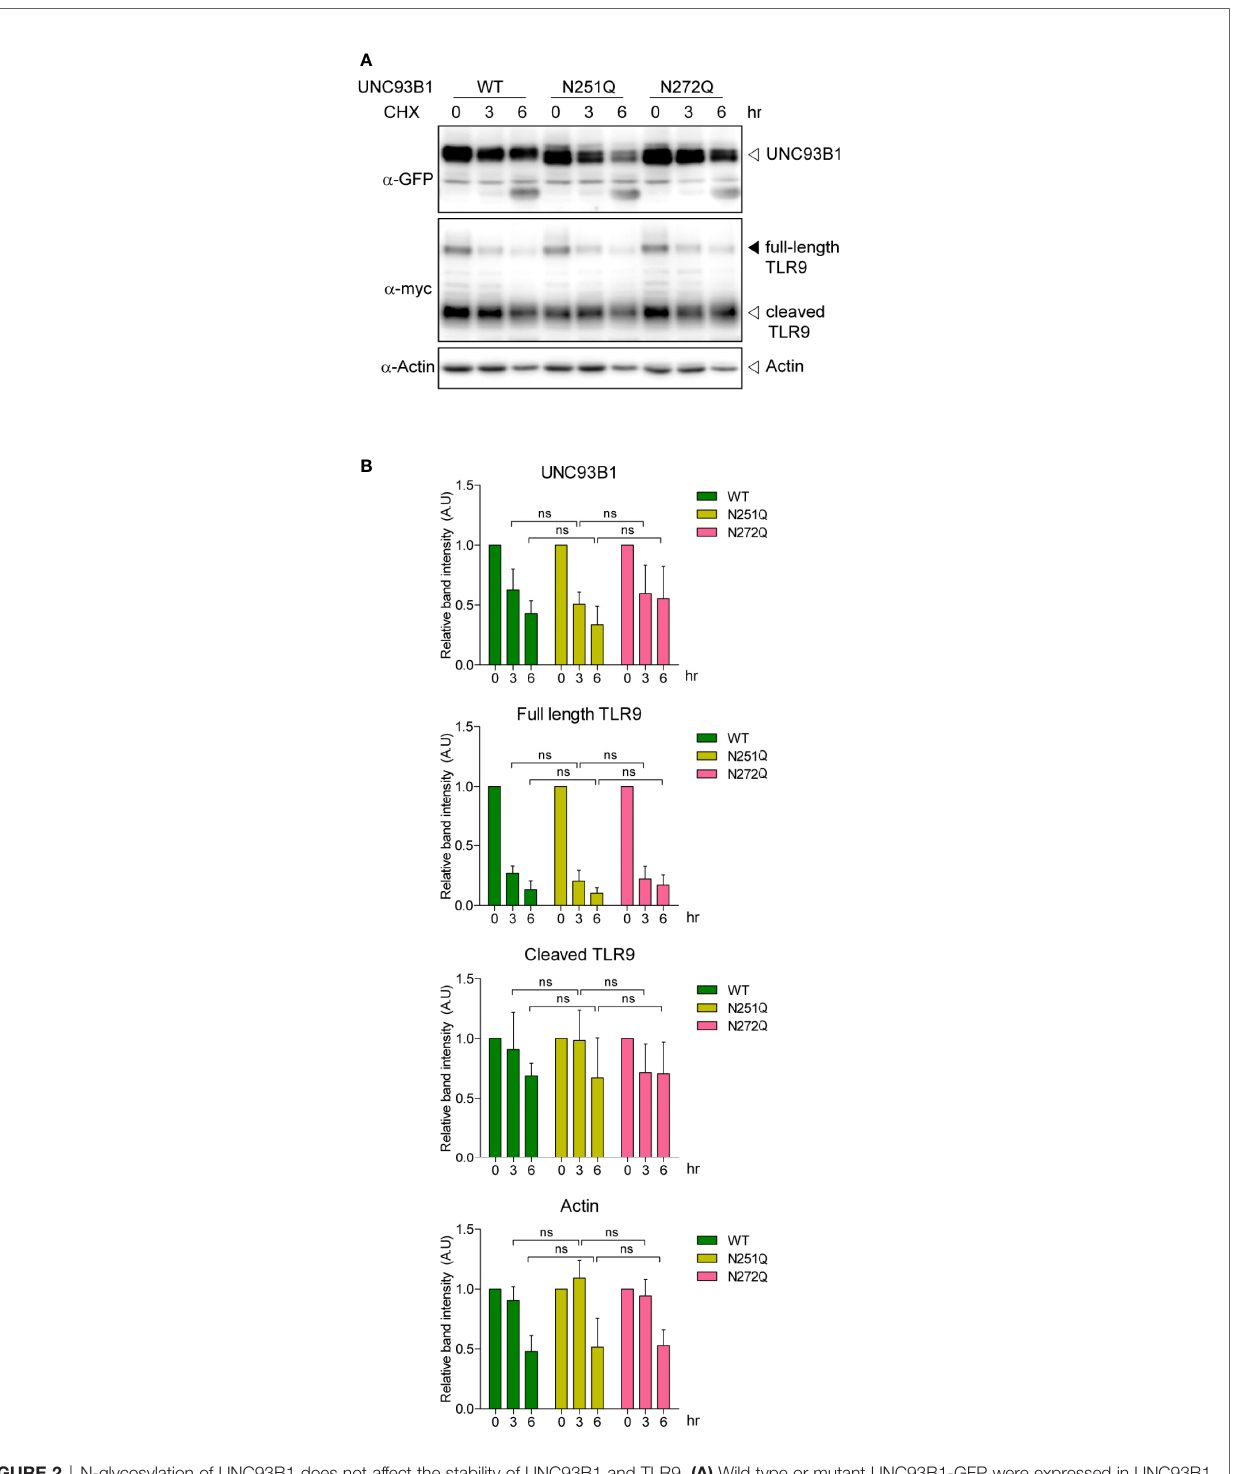
FIGURE 2 | N-glycosylation of UNC93B1 does not affect the stability of UNC93B1 and TLR9. (A) Wild type or mutant UNC93B1-GFP were expressed in UNC93B1 KO iBMDMs together with TLR9-myc. After inhibition of protein synthesis with 20 m g/ml cycloheximide for indicated time periods, cells were lysed and the lysates were loaded on an SDS-PAGE gel. After electrophoresis and protein transfer, UNC93B1-GFP, TLR9-myc, and actin in a single transfer membrane were sequentially detected by immunoblotting with anti-GFP, anti-myc, and anti-actin antibody, respectively. (B) The relative band intensity of UNC93B1, full-length TLR9, cleaved TLR9, and actin at each time point was calculated by dividing the band intensity of individual protein at the indicated time point with that at 0 h. Data represent means ± SD (n = 3). ns, not signi fi cant (Student's t